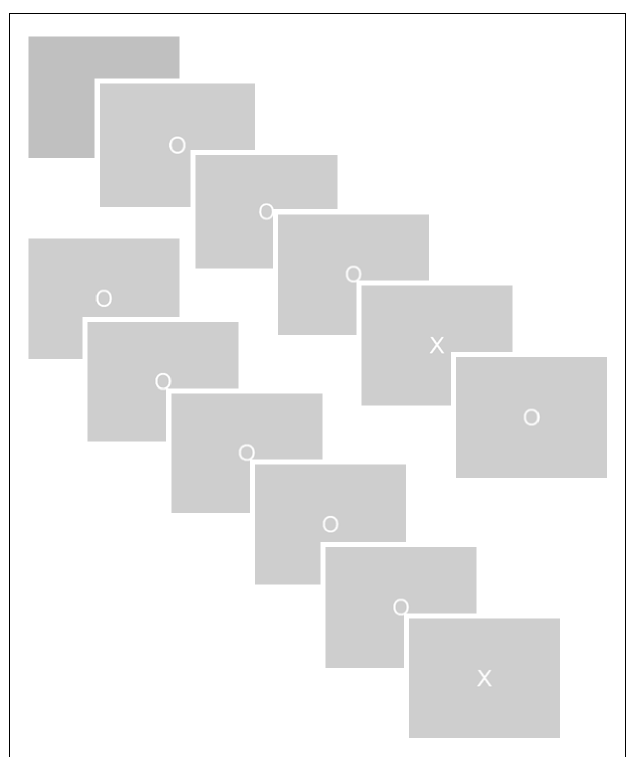
FIGURE 1 | Oddball task. A series of non-target (0) and target (X) images was presented against a gray background.The target- and non-target ranged from 3 to 17 non-targets between targets. Participants were to react as quickly and accurately as possible to targets only by pressing a button with their index